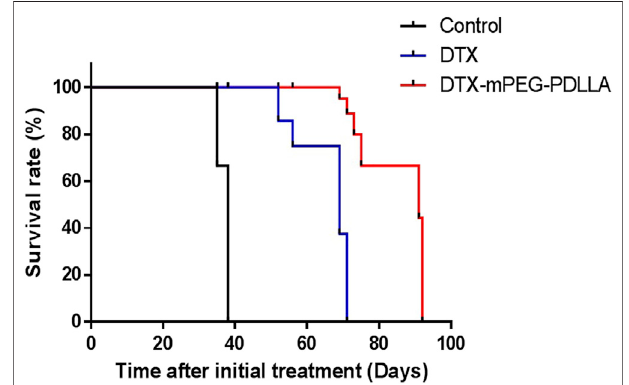
FIGURE 7 | Survival analysis of DTX-mPEG-PDLLA micelles via IP administration in ovarian cancer peritoneal metastasis. Survival curves for SKOV-3 tumor-bearing nude mice receiving different treatments. Mice were treated with NS, DTX, or DTX-mPEG-PDLLA micelles on days 1 and